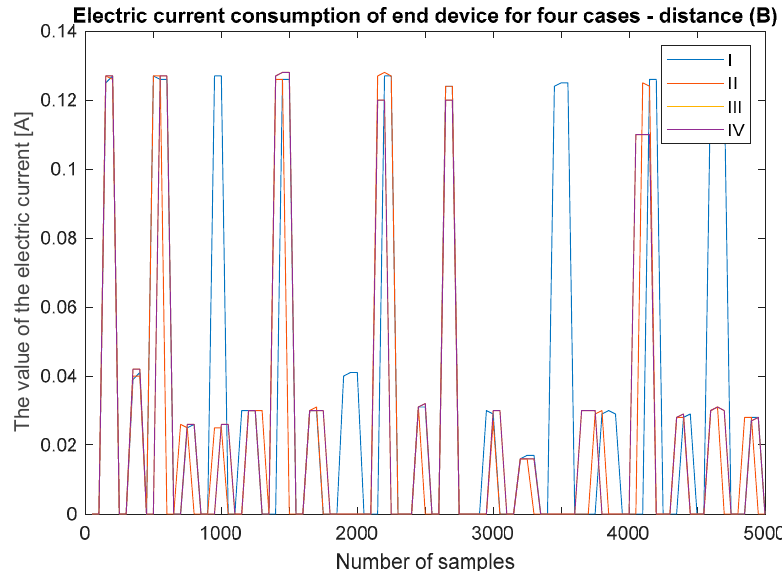
Figure 16. Graph of electric current consumption of the end device for four cases and devices— locations (B).